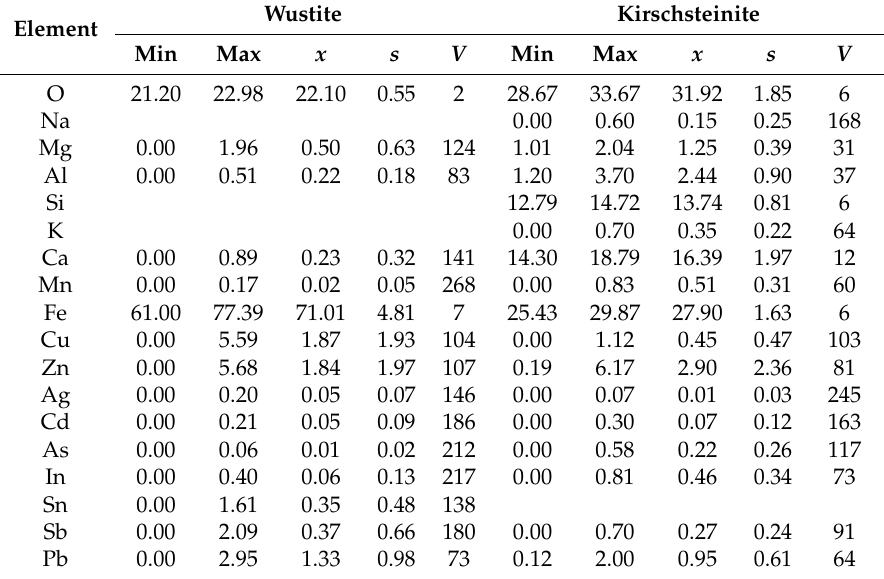
Figure 3. Sample WZIII - example of an image of the investigated micro-areas. 1—kirschsteinite with wustite, 2—glass, 3—Pb-Cu alloy with Au admixture (6%), 4—Pb–Fe–Zn. Table 3. Differentiation of the chemical composition of wustite and kirschsteinite, occurring in the investigated grains of samples taken from the top layer of the landfill.